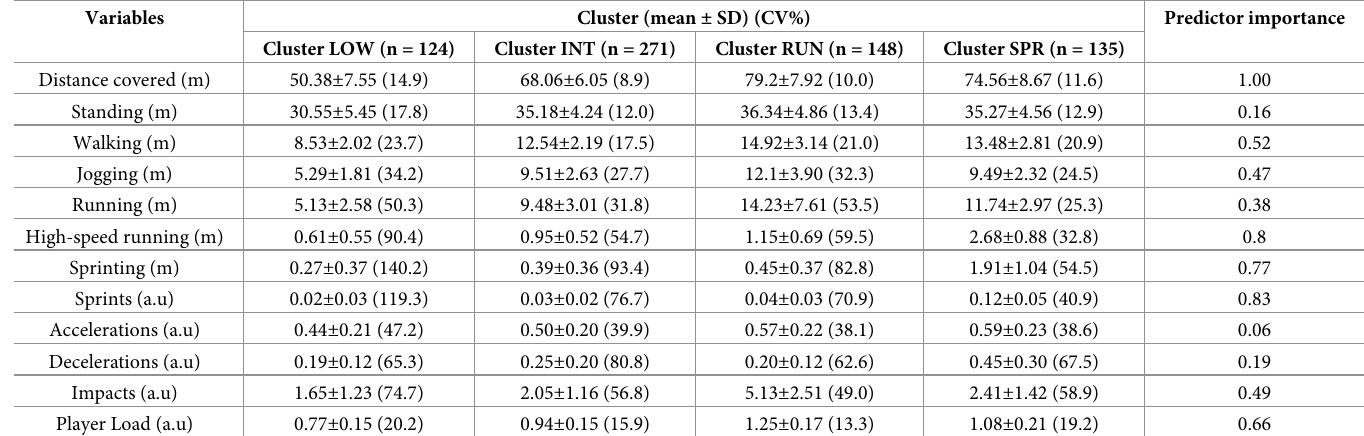
(0.45 ± 0.03), and distance covered at high-speed thresholds (i.e., high-speed running (2.68 ± 0.88), and sprinting (1.91 ± 1.04)).